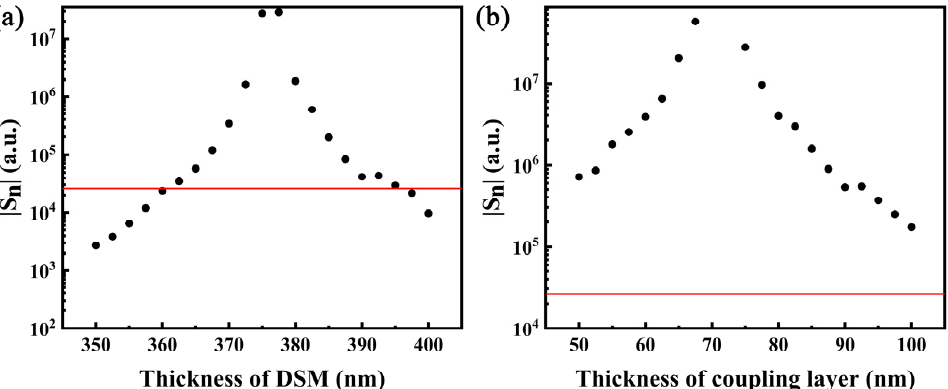
Figure 10. Variation in S n with the thickness of ( a ) DSM (dc = 75 nm) and ( b ) coupling layer (d DSM = 375 nm). The red line in these figures shows the sensitivity of the conventional metal Ag SPR structure as a comparison.